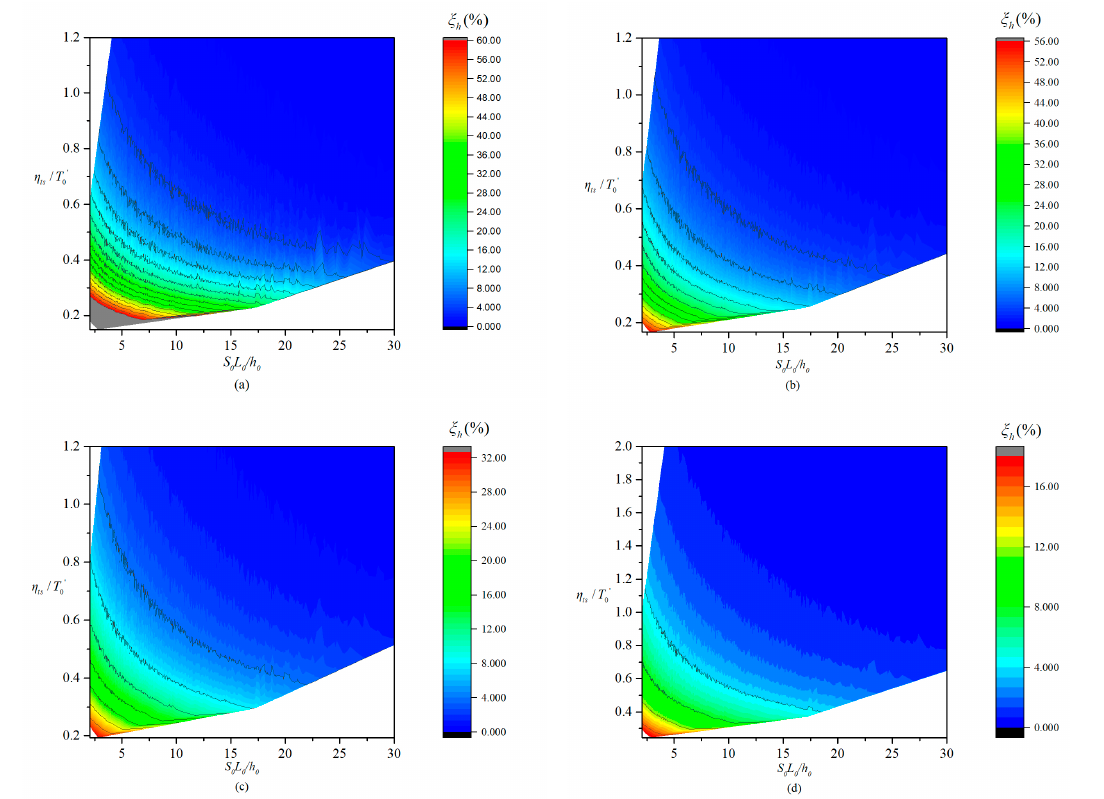
Figure5. Thedistributionofrelativeerror ξ h withvariationsin S 0 L 0 / h 0 and η ts / T . ( a ) Q bottom / Q peak = 0. ( b ) Q bottom / Q peak = 0.2. ( c ) Q bottom / Q peak = 0.4. ( d ) Q bottom / Q peak = 0.6. The numerical tests were designed that Q peak = [ 300, 400, 500 ] , T peak = [ 8 h, 10 h, 12 h ] , α varied from 1.1 to 1.5 with an interval of 0.05, n varied from 0.01 to 0.05 with an interval of 0.002, S 0 varied from 0.0002 to 0.0008 with an interval of 0.0001, and channel width and length were 100 m and 60 km, respectively (all the possible tests according to the selected value of every parameters were calculated). The outermost line in each figure indicates ξ h = 4% with 4% decreasing inward.